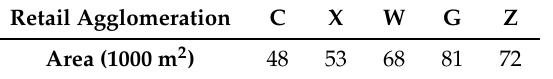
Table 2. The total area of each agglomeration.